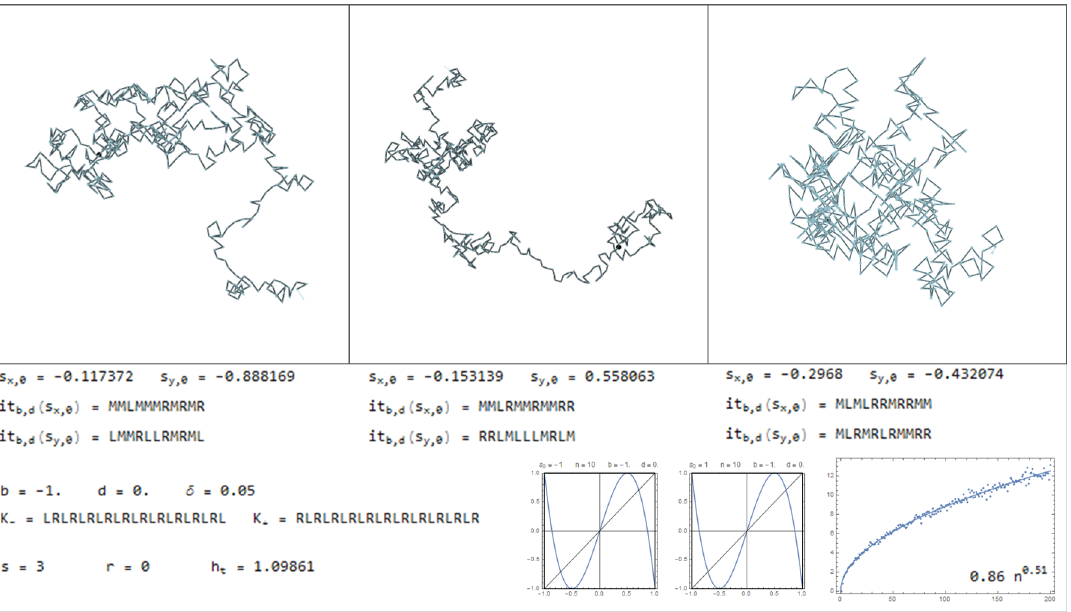
Figure 17. Trajectories produced with b = − 1 and d =